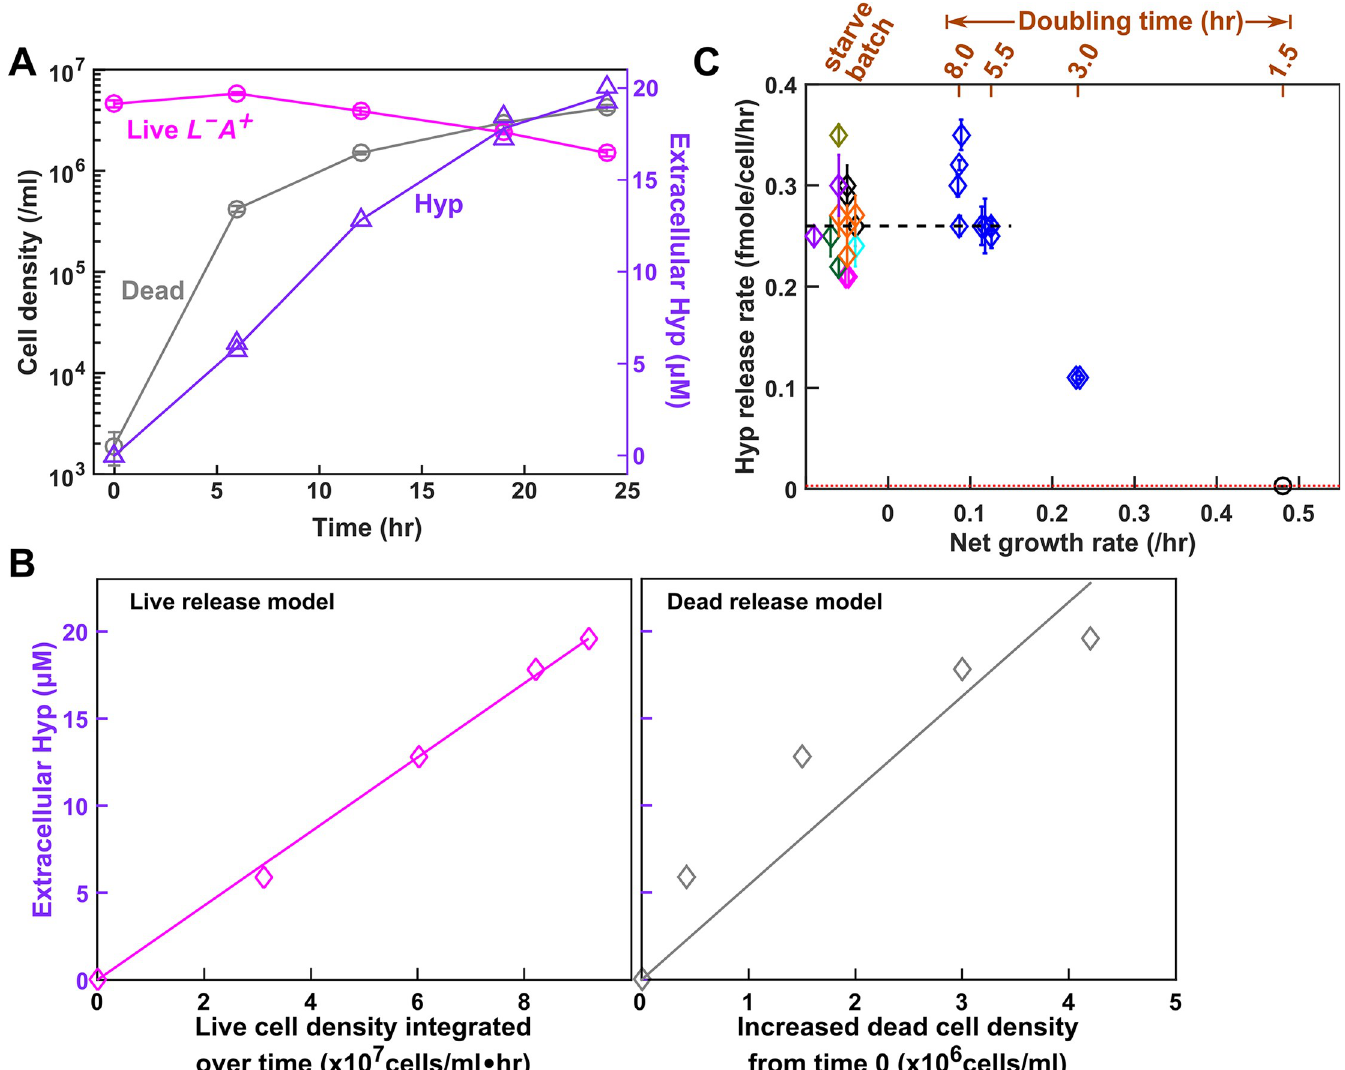
Fig 5. Hypoxanthine is released by live L − A + upon limitation for lysine. ( A ) Hypoxanthine release during lysine starvation. Exponential L − A + cells were washed free of lysine and diluted into SD. Live and dead population densities and supernatant hypoxanthine concentrations were measured over time (Methods, “Flow cytometry”; the yield bioassay in “Bioassays”). ( B ) The “live release” model fits data better than the “dead release” model. (Left) If hypoxanthine was released by live cells at a constant rate, then hypoxanthine concentration should scale linearly against live cell density integrated over time. (Right) If hypoxanthine was released upon cell death, then hypoxanthine concentration should scale linearly against dead cell density. The live release model has better linearity than the dead release model, and therefore hypoxanthine is likely released by live cells. The release rate measured in the left panel of B was used in Models i and ii. Data for A and B can be found in S5 Data. (C) Hypoxanthine release rate as a function of growth rate. Hypoxanthine release rates were plotted for L − A + in the presence of excess lysine (black circle on the right), in lysine-limited chemostats with doubling times ranging from 3 to 8 h (blue; S14 Fig blue), and during lysine starvation (plotted at < 0 net growth rate, with different colors indicating experiments on different days). The black dashed line marks the average release rate measured from starvation up to 5.5-h chemostats (Table 1), which was used in Model iii. Hypoxanthine release rate in excess lysine was lower than the detection limit (i.e., < 0.003 fmole/cell/h, marked by the red dotted line; Methods, “Measuring the upper bound of release rate in excess metabolites”). Release rates of L − A + are in S7 Table. Hyp, hypoxanthine; SD, Synthetic Dextrose minimal